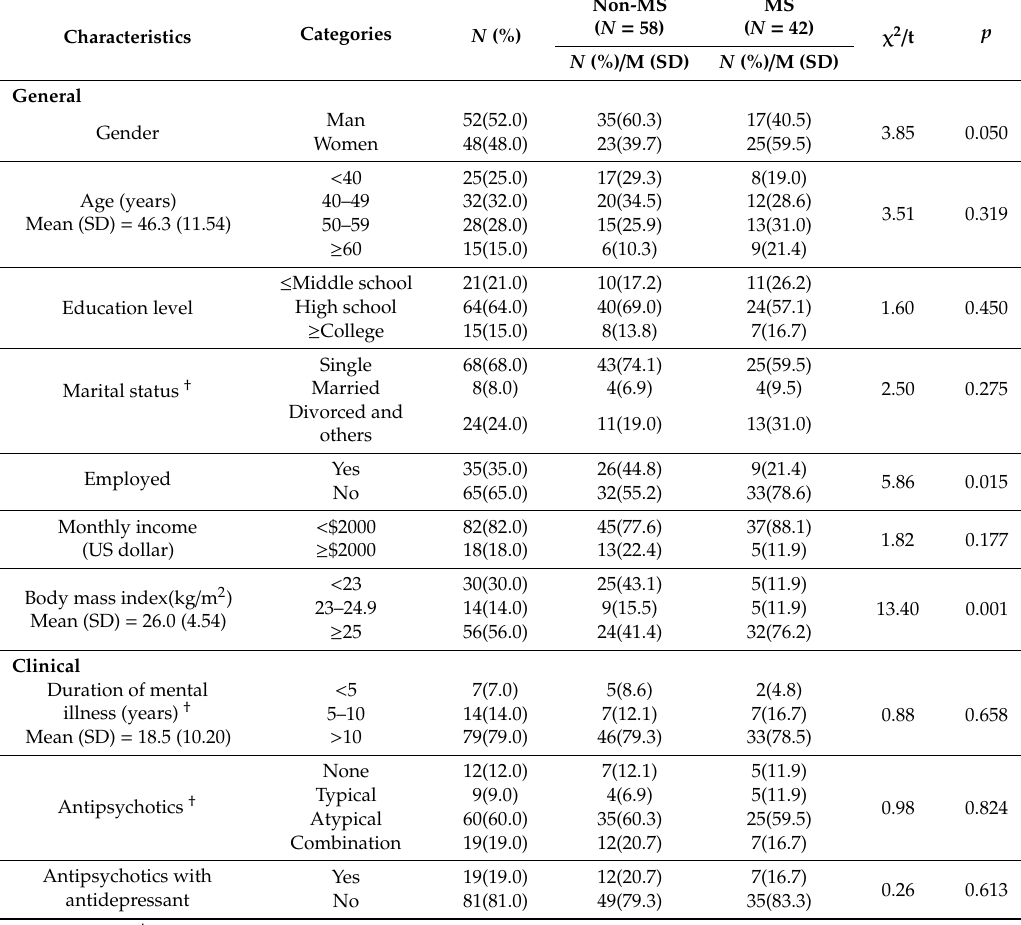
Table 2. Comparison of the characteristics of study subjects with and without metabolic syndrome ( N =